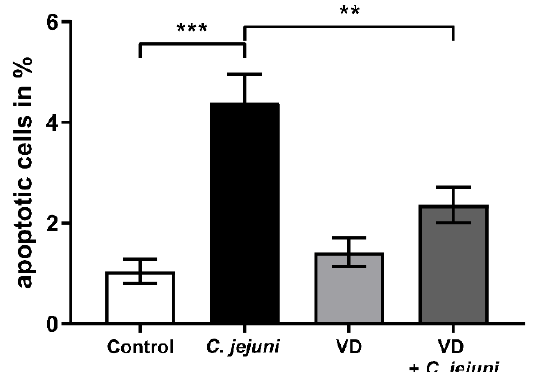
Figure 6. Vitamin D prevents epithelial cells from C. jejuni -induced apoptosis. C. jejuni -infected HT-29/B6-GR/MR cells were treated with 200 nM vitamin D (VD). After 48 h of infection, cells were stained for apoptotic cells with TUNEL reagent, and visualized by confocal laser-scanning microscopy. Nuclei were stained blue with 4´,6-diamidino-2-phenylindole (DAPI) and counted in relation to TUNEL-positive signals. The number of apoptotic cells was estimated in six low-power fields per sample (** p < 0.01, *** p < 0.001, one-way ANOVA with Bonferroni correction, n =